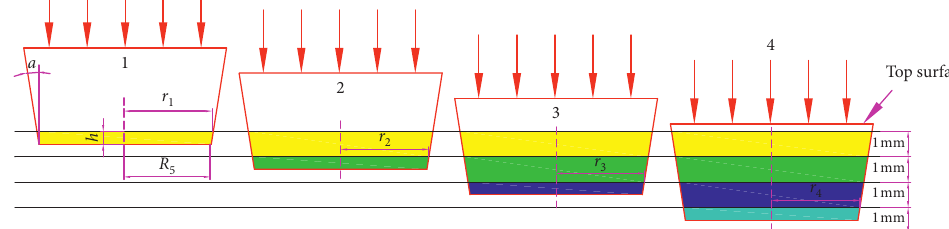
Figure 9: Distributions of the volumetric heat flux in the pin-plunging stage at different steps in the MAM.